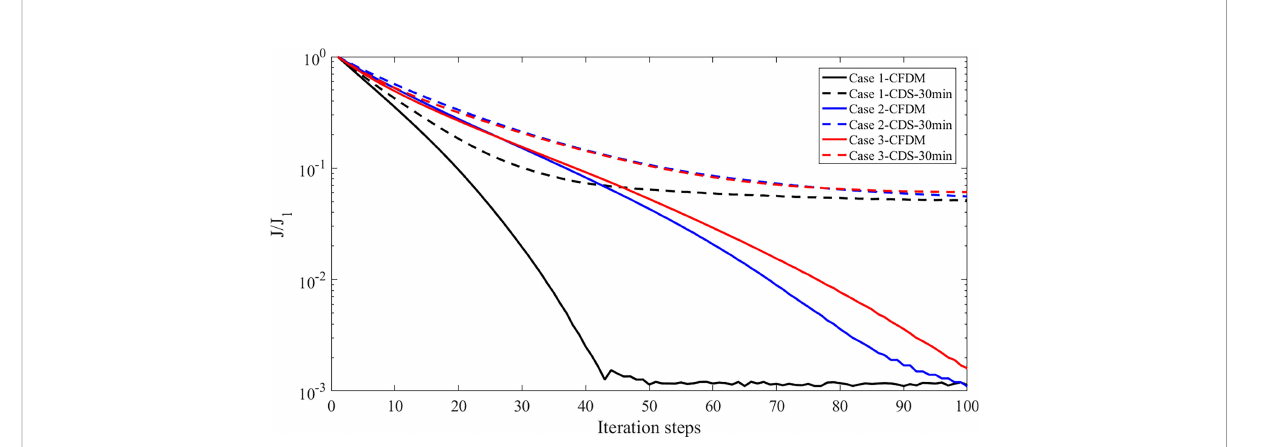
FIGURE 5 The values of the normalized cost function ( J / J 1 ) versus the iteration steps.